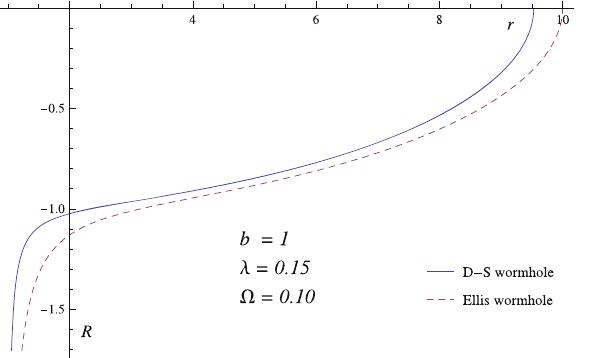
Fig. 2 Ratio between the Casimir energy densities around both D–S and Ellis wormholes and the Minkowsky one, as a function of the radial coordinate, r > b r